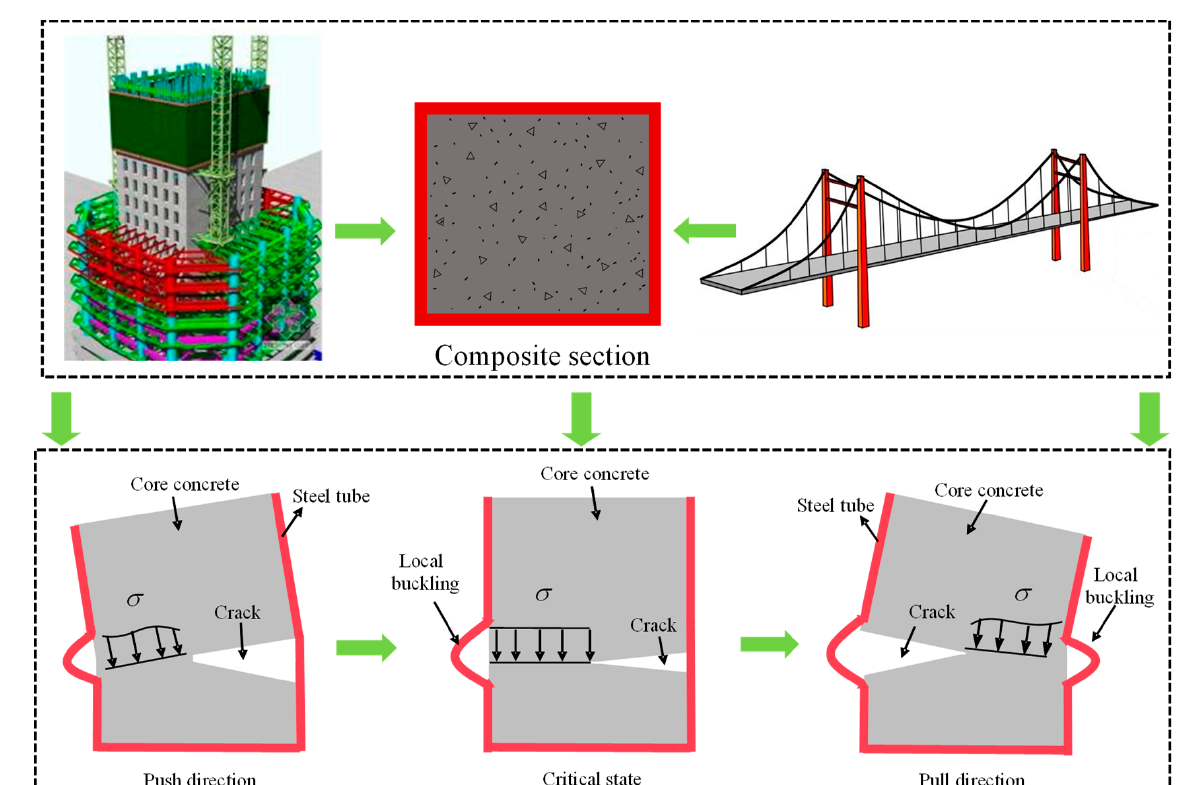
Figure 1. Application of CFSTs in structural engineering and its local buckling e ff ects.